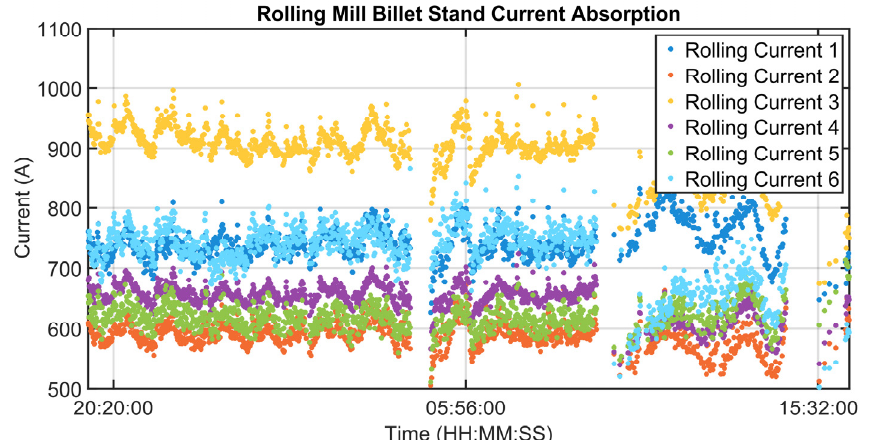
Figure 11. Control results: billets rolling mill load.